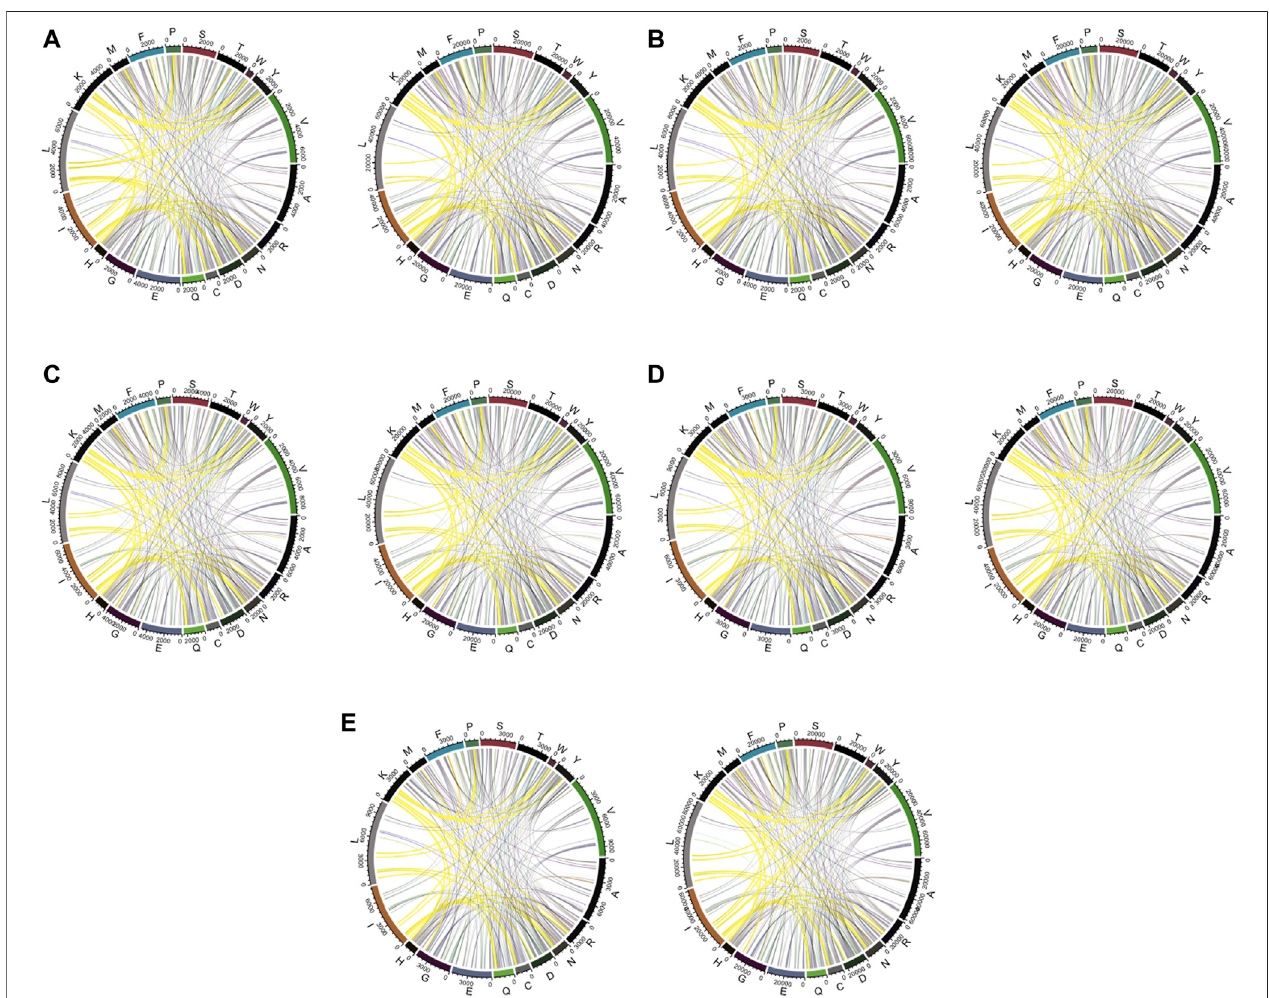
FIGURE6| Chorddiagramofawindowsizeof (A) 10, (B) 15, (C) 20, (D) 25,and (E) 30.Thelinkedlinesshowthecontactbetweenresidues.Highlightedcontacts are compared among various window sizes. For each sub-graph, the left one is from positive samples and the right one from negative samples.